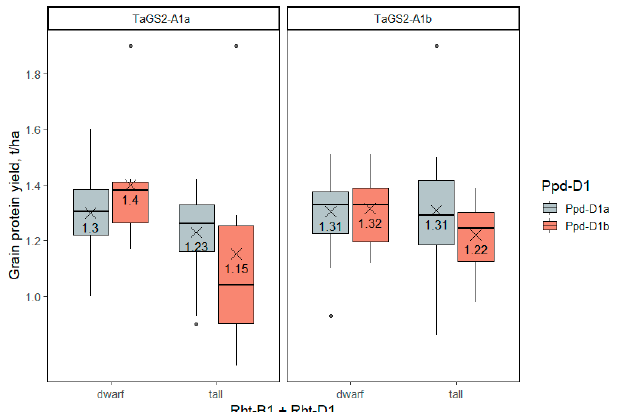
Figure 9. Grain protein yield (t/ha) in winter wheat accessions differing in Rht-1 , Ppd-D1 and TaGS2-A1 genotypes. The dots indicate